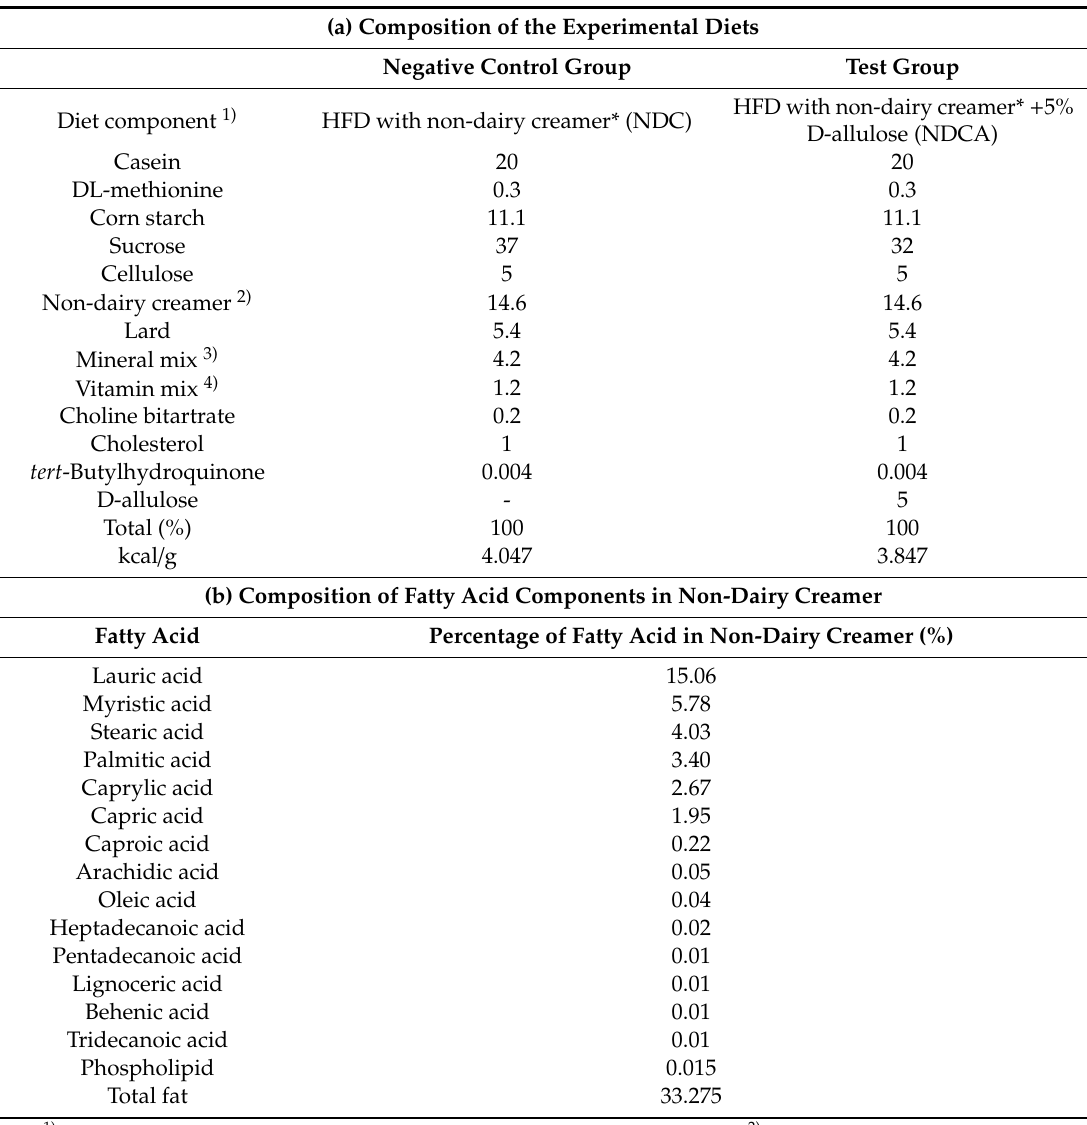
Table 1. Composition of the experimental diets and fatty acid components in non-dairy